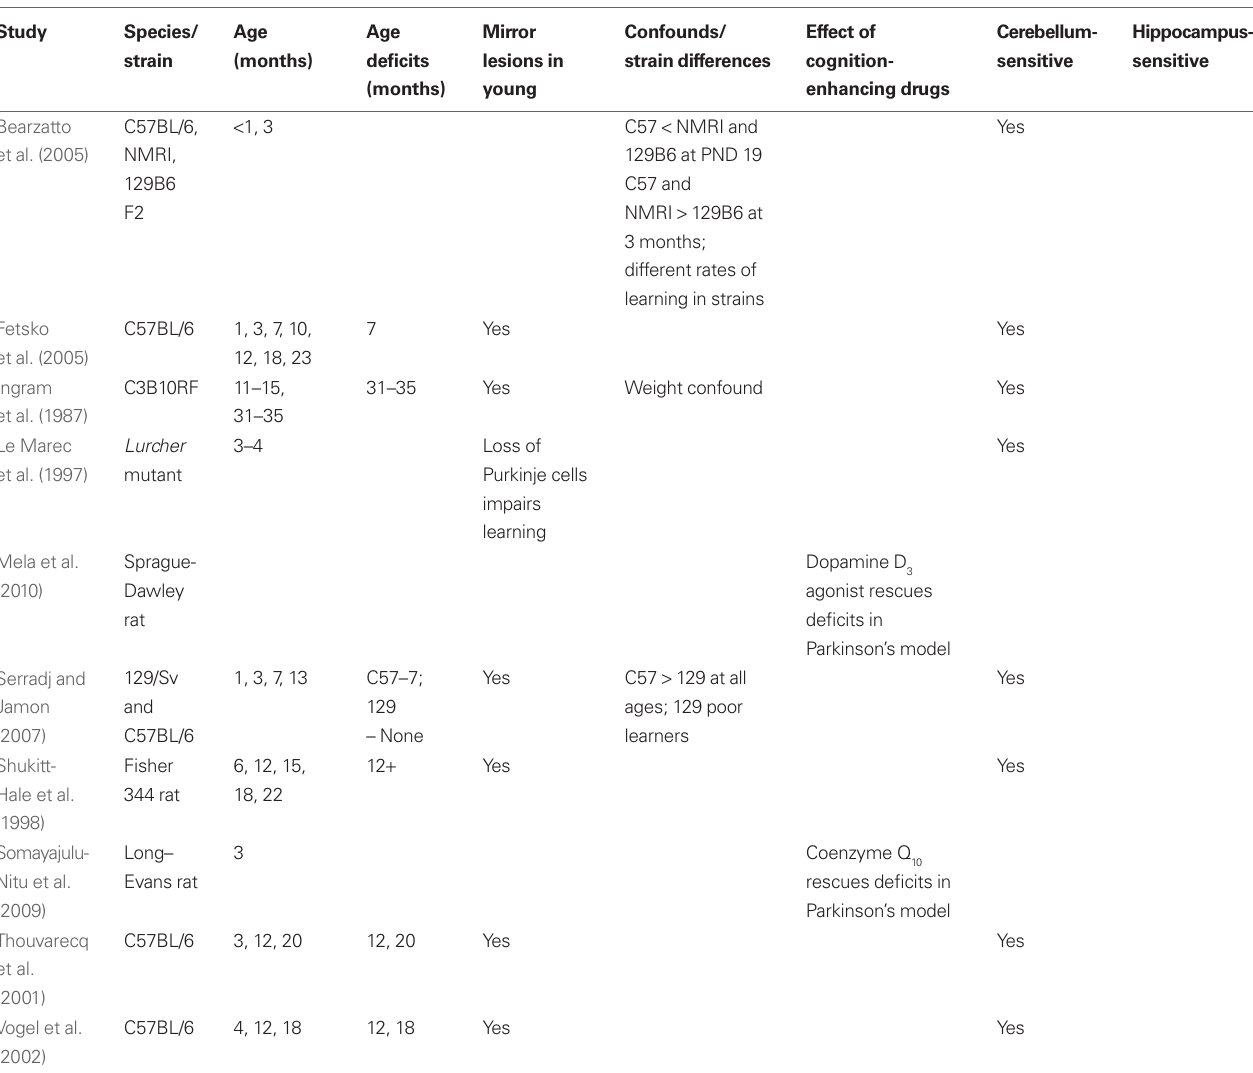
Table 3 | rotorod: age